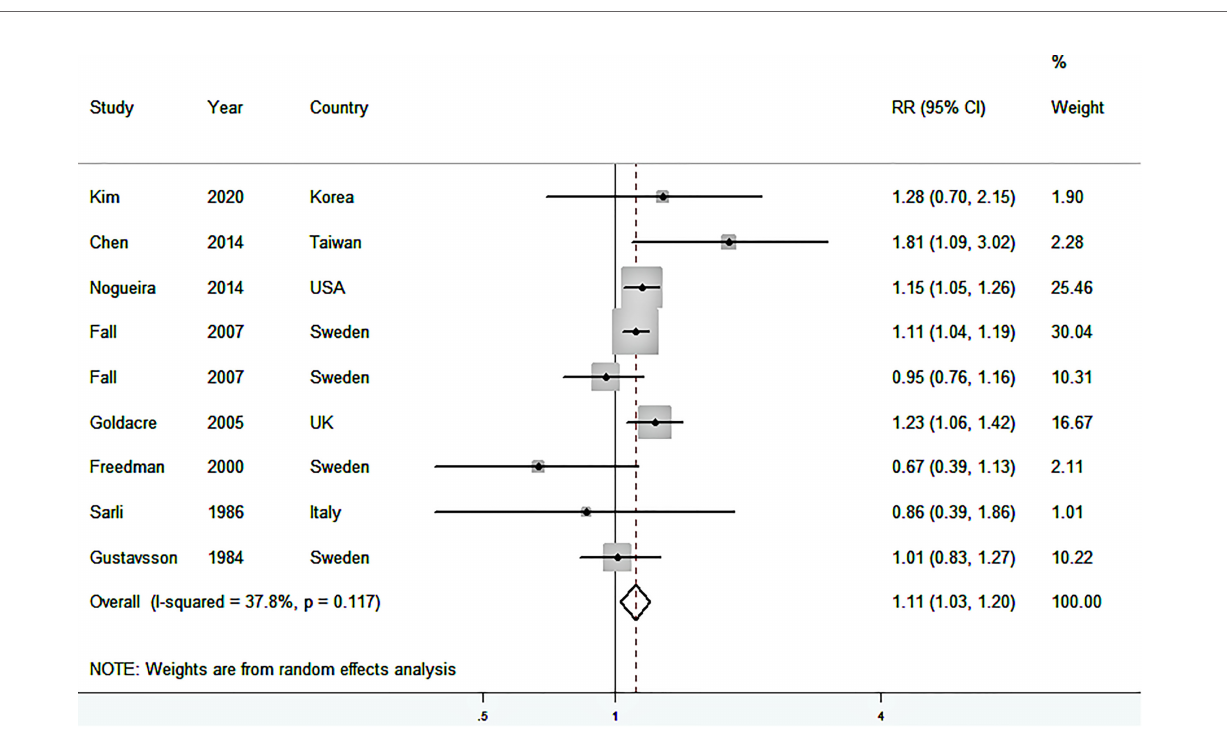
FIGURE 2 | Forest plot (random-effects model) of the association between cholecystectomy and gastric cancer risk. Squares indicate study-speci fi c relative risk (RR), where the size of the square re fl ects the study-speci fi c statistical weight; horizontal lines indicate the 95% con fi dence interval (CI); diamonds denote the summary RR with 95%